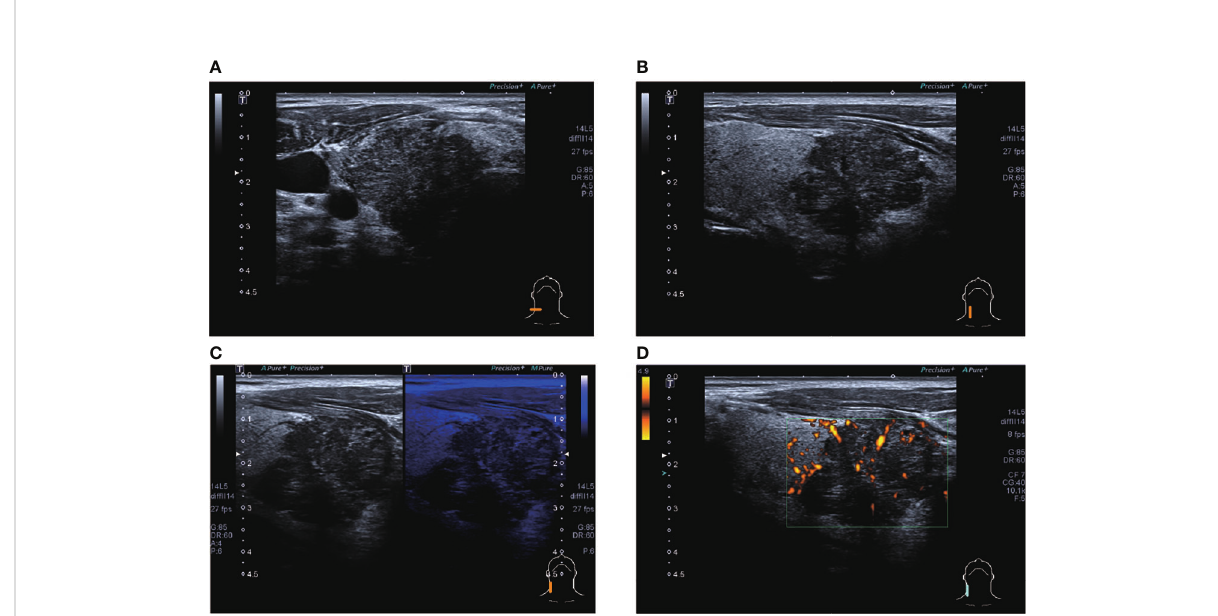
FIGURE 4 ultrasound images of patient #4 showing a hypoechoic nodule, which appears to be lobulated, in the lower pole of the right lobe of the thyroid gland, with punctate calci fi cations visible within. CDFI shows a grade 1 blood fl ow signal. The patient ’ s postoperative pathology was that of a highly differentiated squamous carcinoma, which has not recurred to date. (A) Lateral scan (B) Sagittal scan (C) "Fire fl y" technique (D)